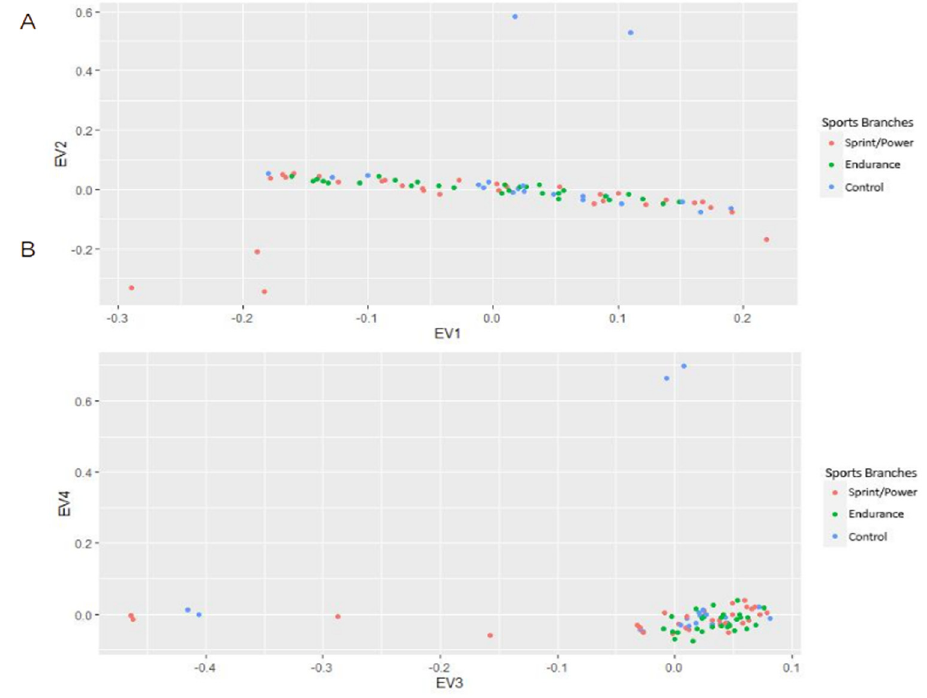
Figure 2. Principal component analysis on the SNP matrix showing genotype distributions across different groups in EV1 − EV2 ( A ) and EV3 − EV4 ( B ) planes.